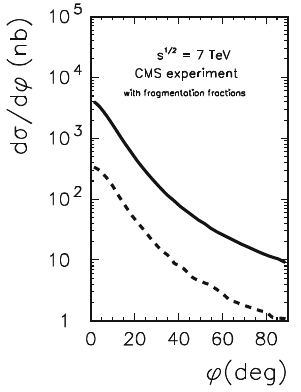
Fig. 7 Azimuthal correlations between c ¯ c that fullfill the condition k rel < 0.2GeV.HeretheCMScutswereimposed.Weshowcontribution of SPS (solid line) and DPS (dashed